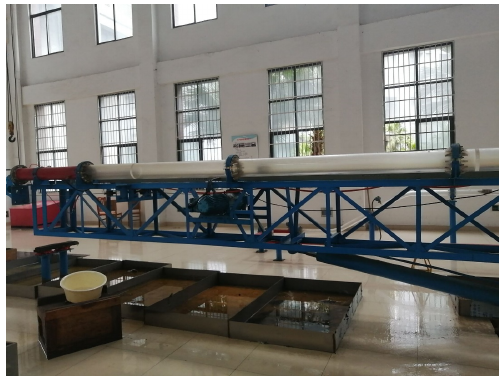
Figure 4. Schematic diagram of simulated wellbore. Table 2. Measurement points of gas–water two phase